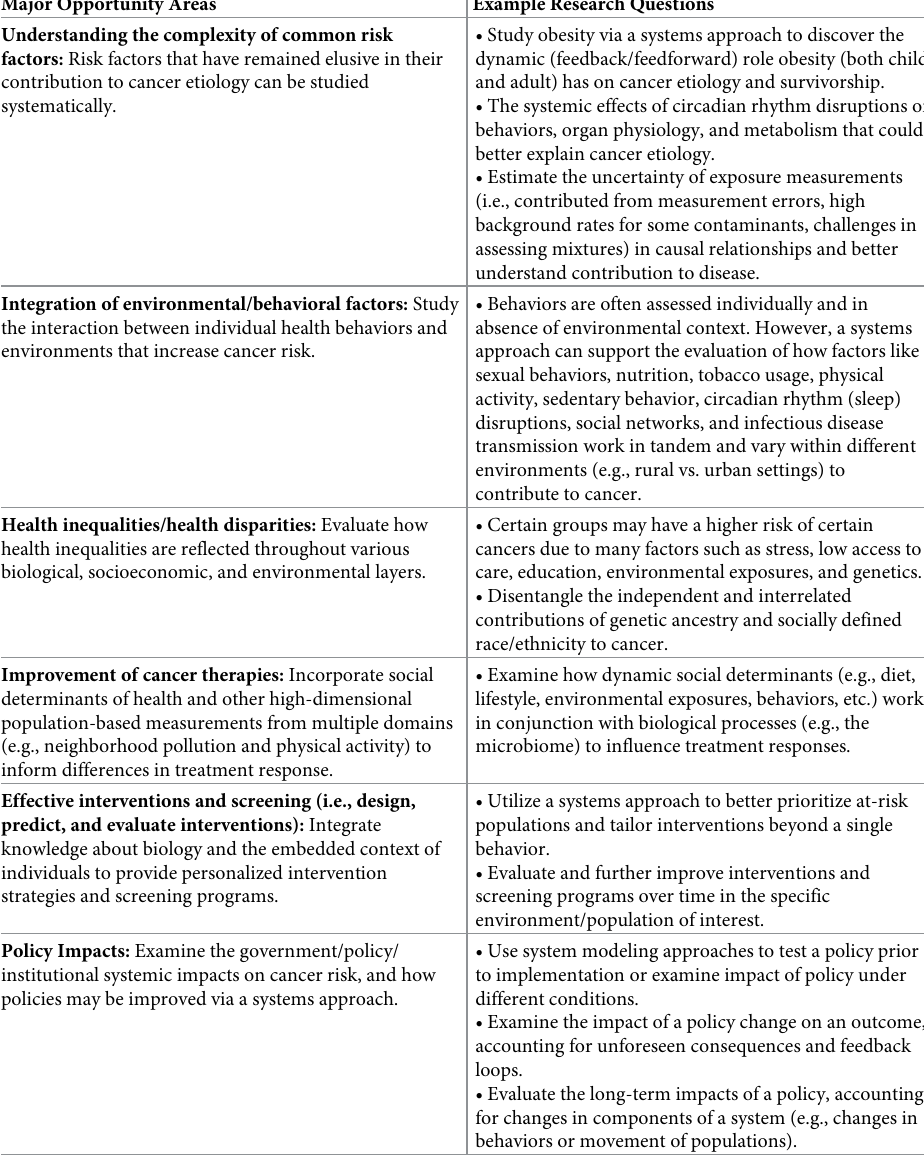
Table 3. Example opportunities for a systems epidemiology approach in cancer